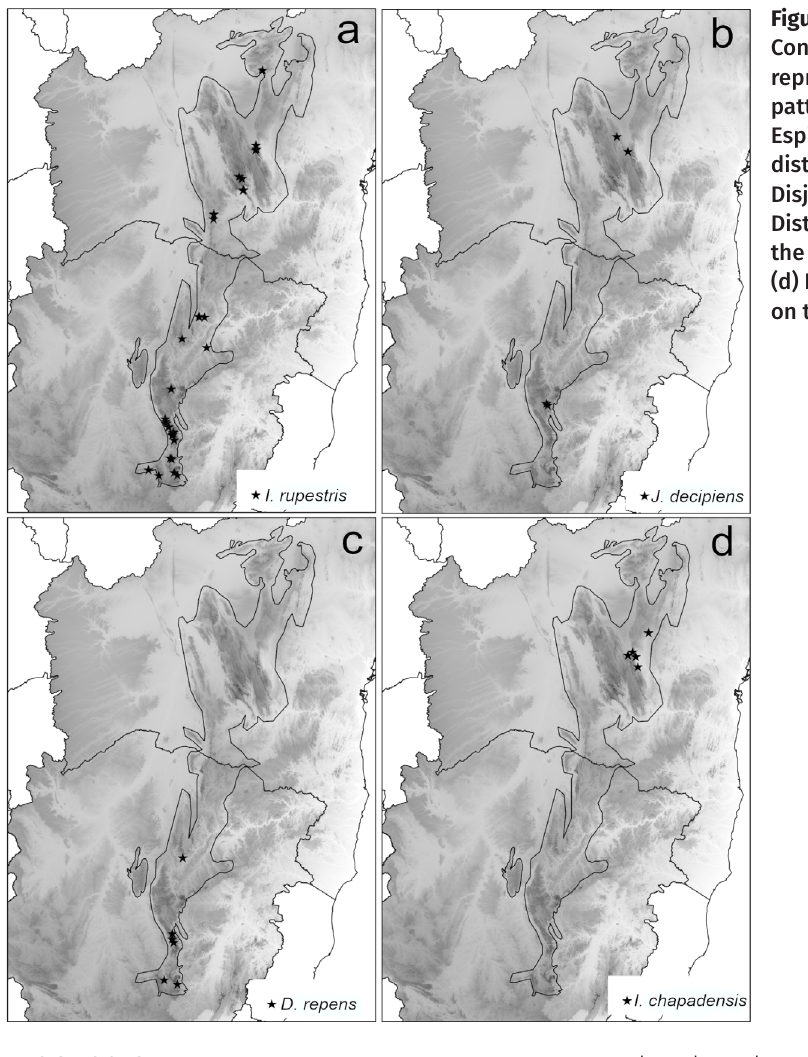
Figure 2. Examples of Convolvulaceae species representing all four distribution patterns found throughout the Espinhaço Range (a) Continuous distribution pattern (b) Disjoint distribution pattern (c) Distribution pattern centered on the Minas Gerais portion (ERMG) (d) Distribution pattern centered on the Bahia portion